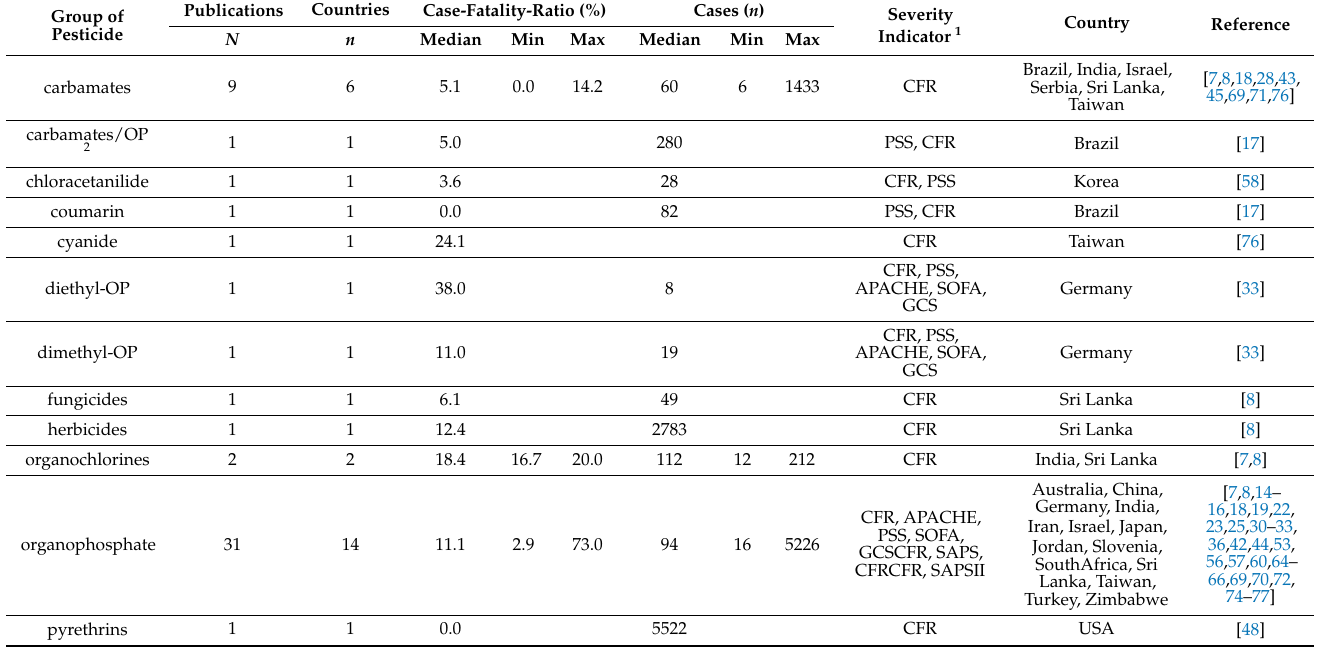
Table 1. Study characteristics and case fatalities for reported groups of pesticides and active